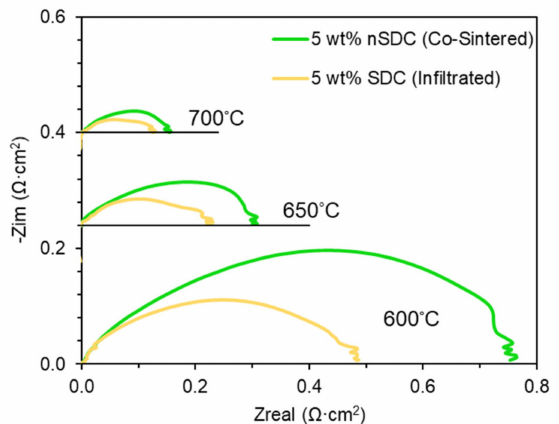
Figure 6. Nyquist plots comparing co-sintered LSCF-SDC-nSDC and LSCF-SDC infiltrated with SDC symmetrical cells at 600 ◦ C, 650 ◦ C, and 700 ◦